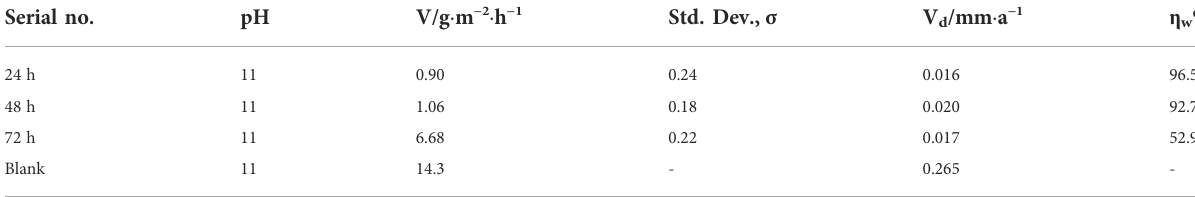
TABLE 2 Comparison of effective weight loss for Al alloy 6101 coated and blank samples in the NaOH corrosion solution (pH 11). Serial